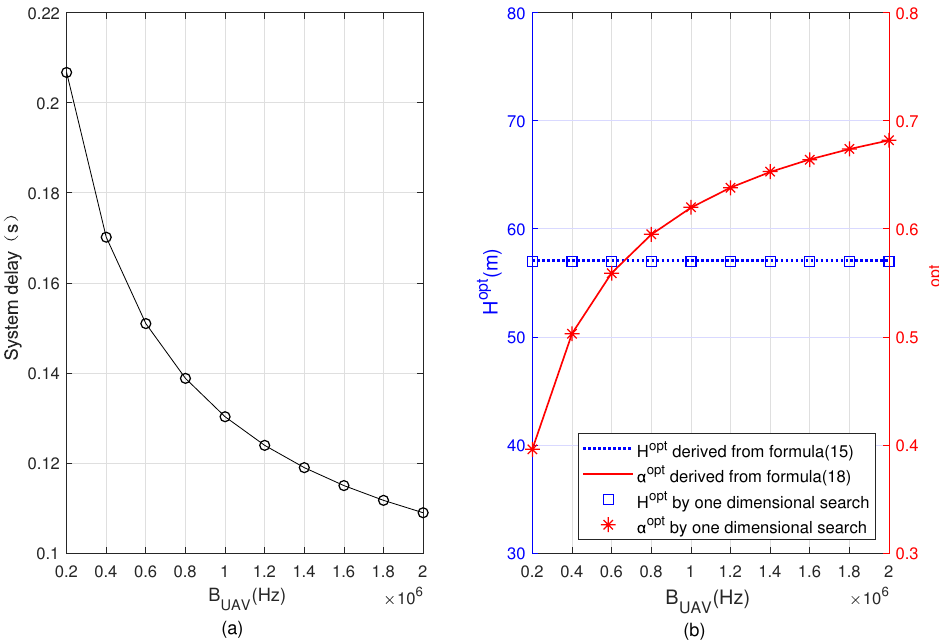
Figure 4. Minimum system delay, optimal flying altitude, and optimal task allocation ratio versus bandwidth allocated to UAV for task offloading. ( a ) Minimum system delay, ( b ) optimal flying altitude and optimal task allocation